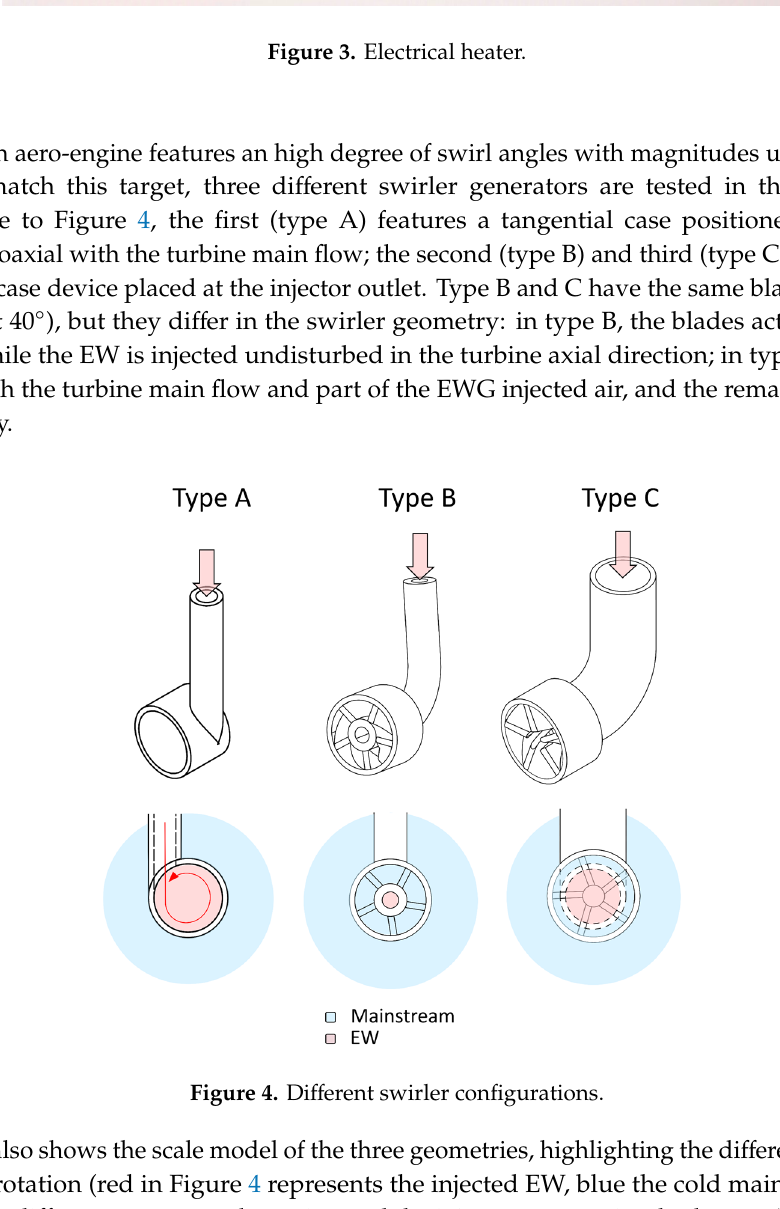
Figure 4. Different swirler configurations.